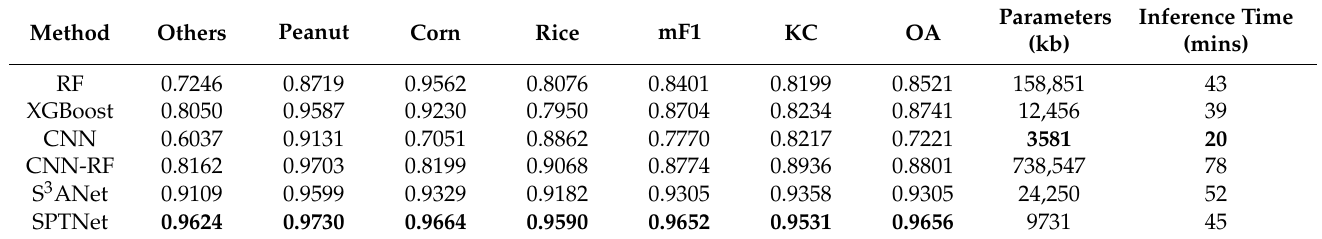
Table 4. The quantitative comparison between the proposed method and the mainstream method in the accuracy evaluation index on the Henan crop dataset. The optimal accuracy is bolded. The inference time is obtained by averaging the inference time of each Sentinel-2 image.